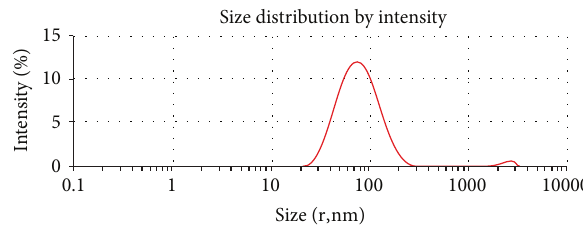
Figure 4: Ag NPs size distribution at 25 ∘ C detected by DLS.